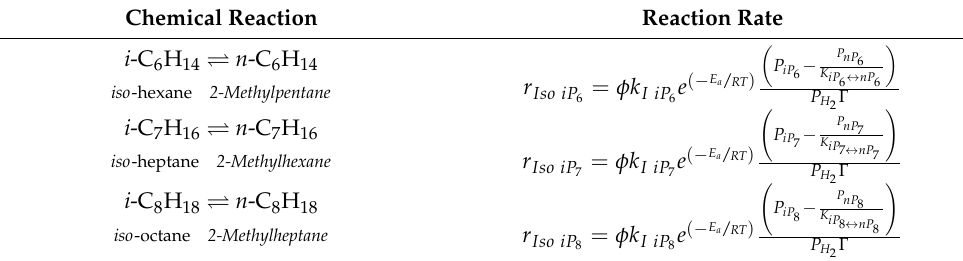
Table 5. Isomerization of paraffins.